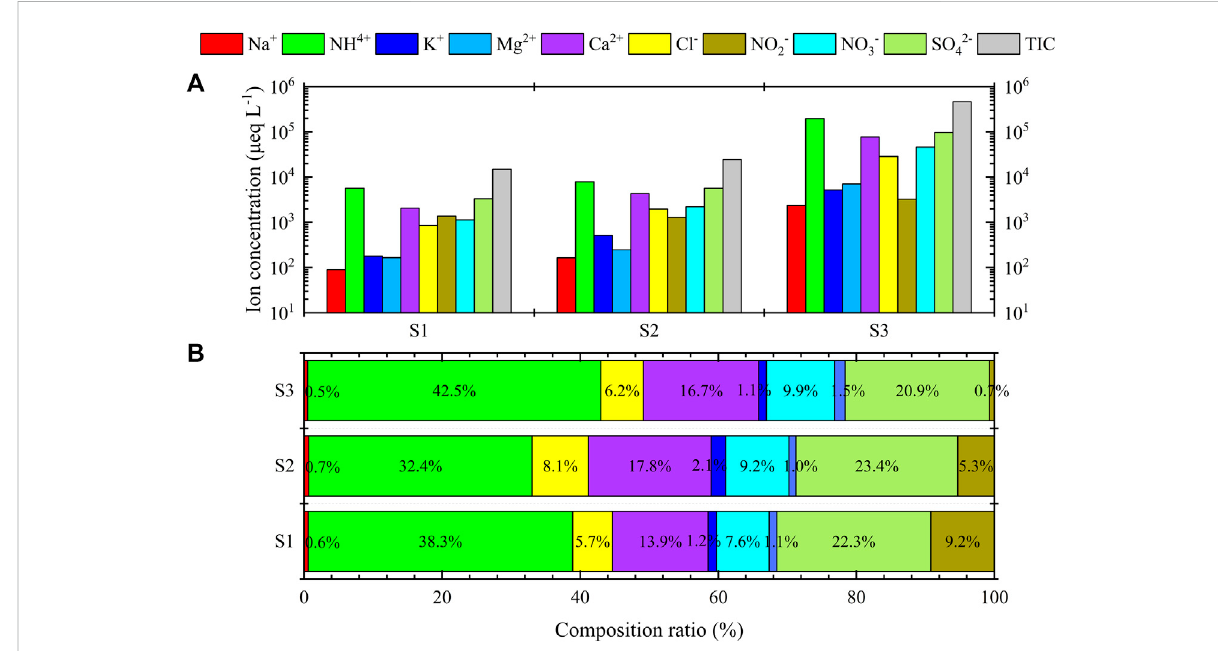
FIGURE 4 (A) Watersolubleionconcentrationand (B) theratioofeachcomponentinthree-stagefogwaterinDonghaisite.TICistotalionconcentration. The S1, S2, and S3 represent the sample for the large droplets of diameter larger than 22 μ m, medium droplets of diameter within 16 – 22 μ m, and small droplets of diameter within 4 – 16 μ m,